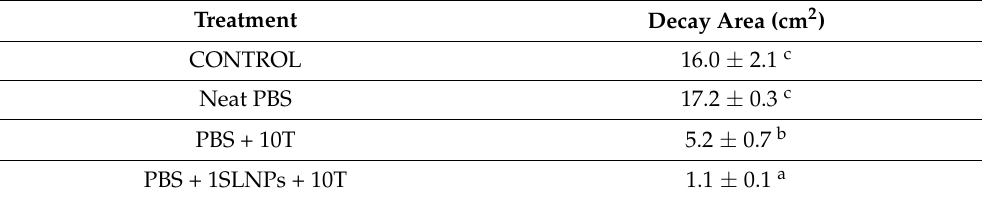
Table 5. Total area of decay on day